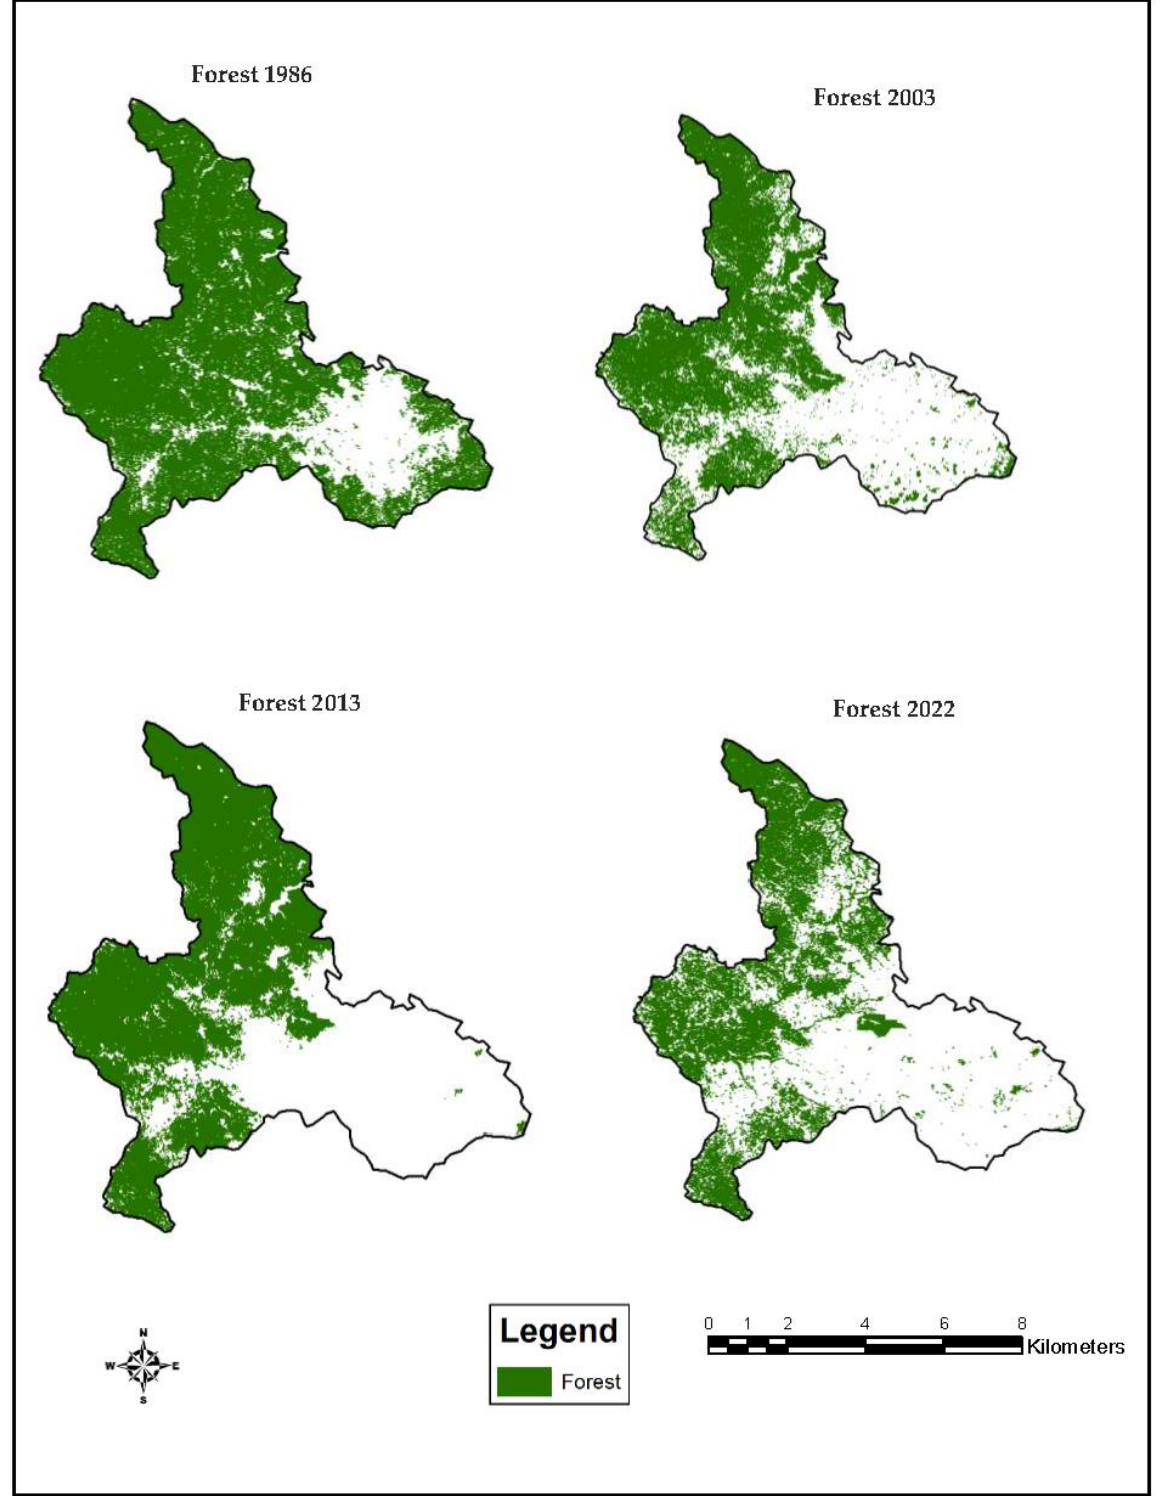
Figure 9. Forest extent maps.